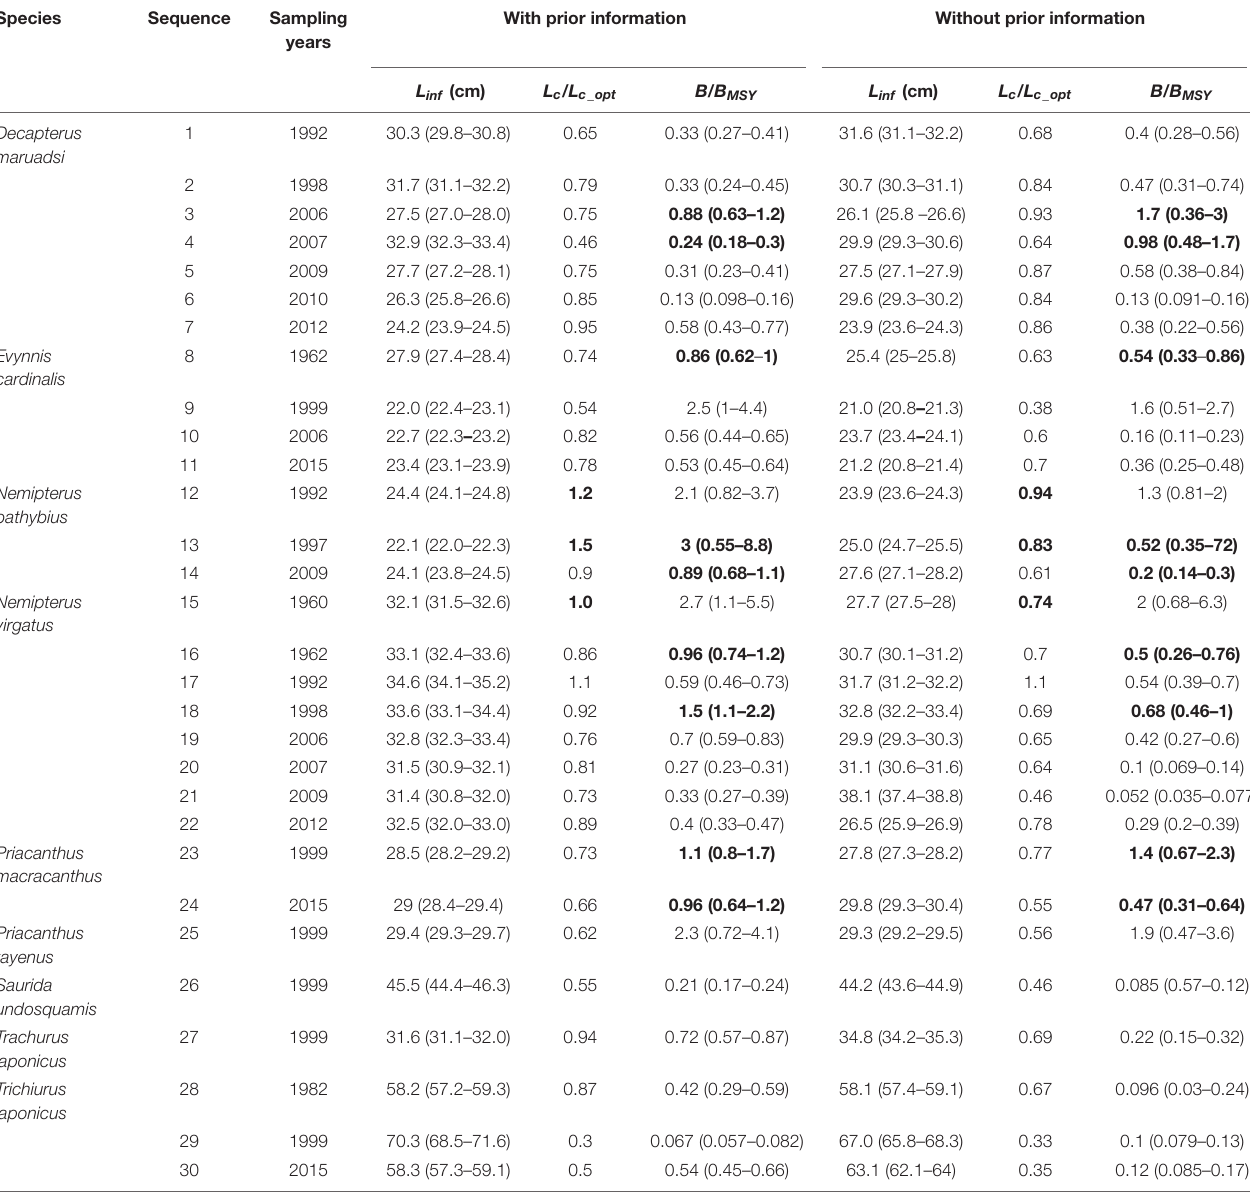
TABLE 3 | Comparison of assessment results of LBB method with and without prior information. Species Sequence Sampling With prior information Without prior years